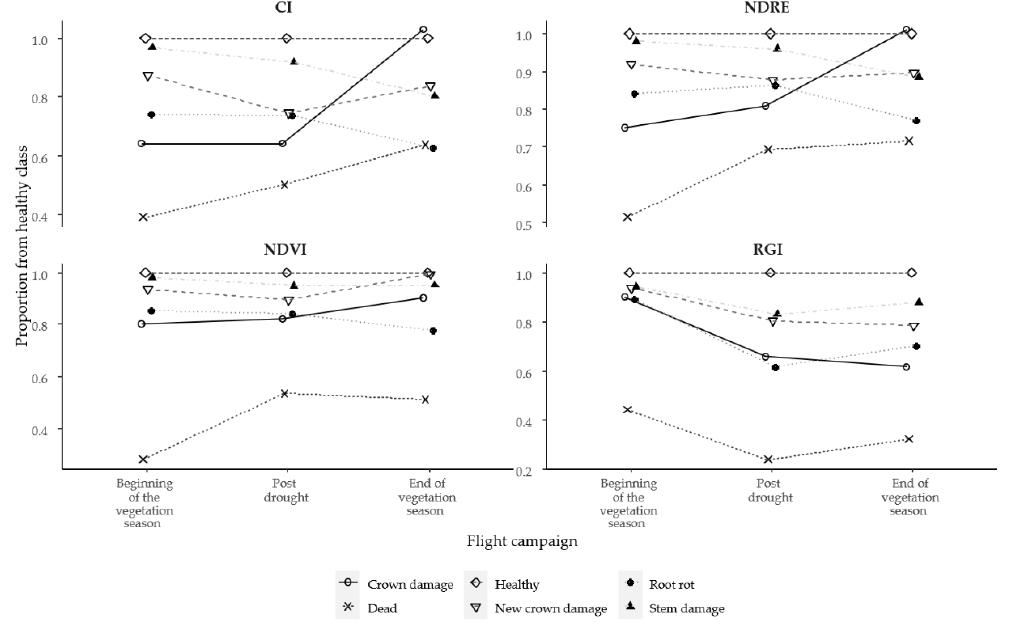
Figure 6. The relationships between vegetation indices and tree health classes; differences are shown as a relative difference to Healthy trees. as a relative difference to Healthy